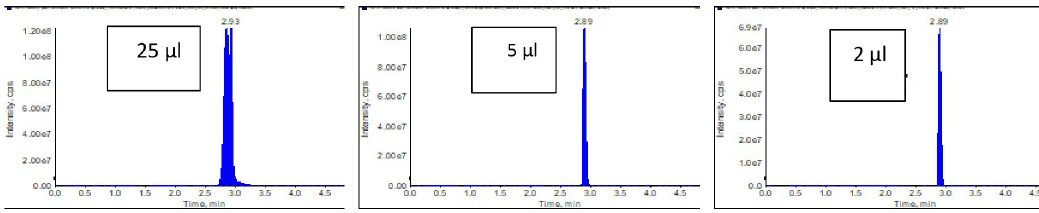
Fig 4. Extracted ion chromatogram of azoxystrobin 50 ppb, injection volume of 2, 5, and 25 μ L. a 5 μ L injection volume was chosen to achieve maximum detection and quantification limitations.